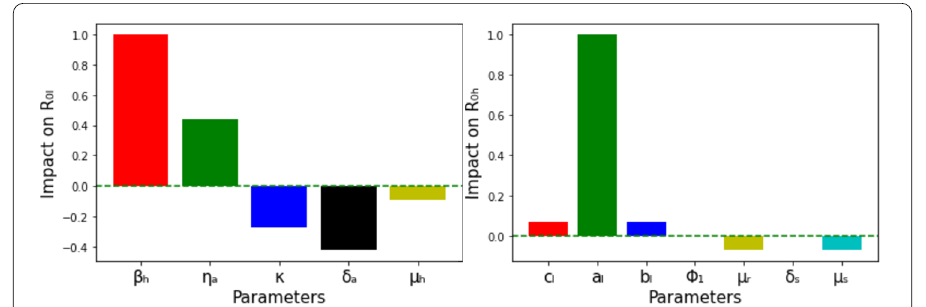
Table 3 Parameter values of the VL–HIV co-infection model Parameter Value day –1 Source (cid:4) h 0.03 Assumed (cid:4) s 0.2999 × N s [38] (cid:4) r 0.0073 × N r 0.0000395 0.189 0.29 varies varies